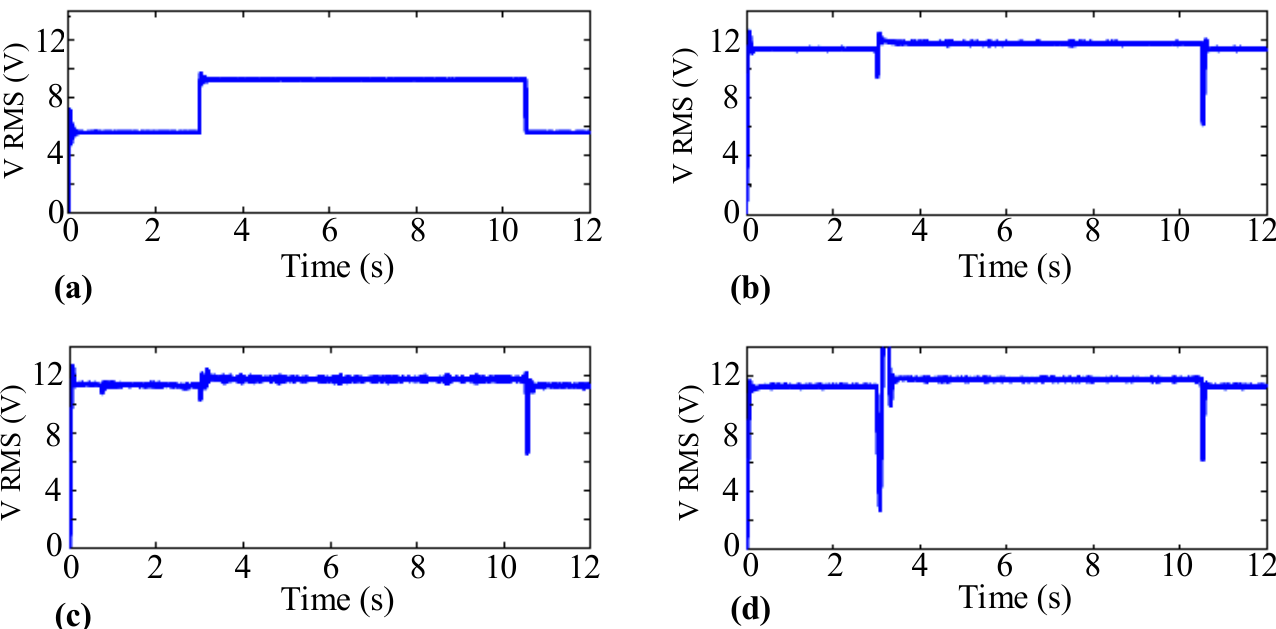
Figure 16. Effective voltage changes in the first scenario using ( a ) the first strategy, ( b ) the second strategy, ( c ) the third strategy, and ( d ) the fourth strategy. Table 1. Comparison of steady-state values of active and reactive power in the first scenario.